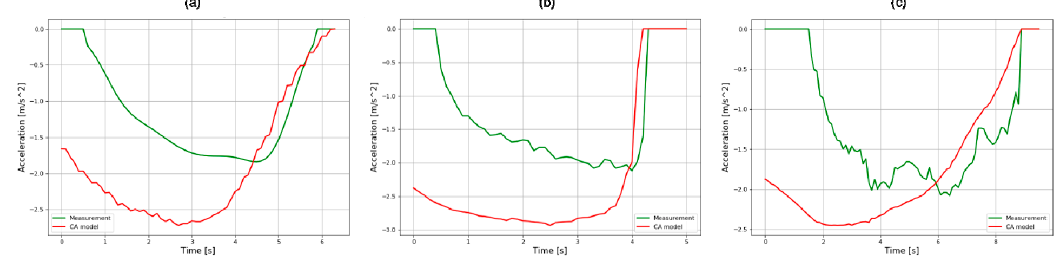
Figure 4. Deceleration profiles in ( a ) car-following; ( b ) speed hump; and ( c ) intersection.